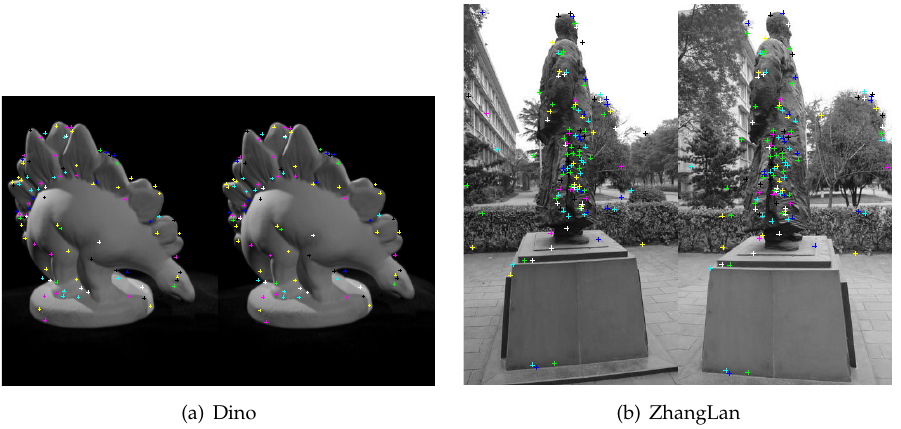
Figure 2. Feature matching for F matrix computation. ( a ) Dino . ( b ) ZhangLan . The matching of Simu are shown in Figure 3, and were produced from a human-made scene. Different feature colors distinguish the different feature